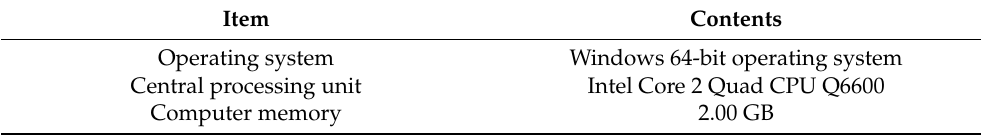
Table 1. The computing configurations for calculating MSO